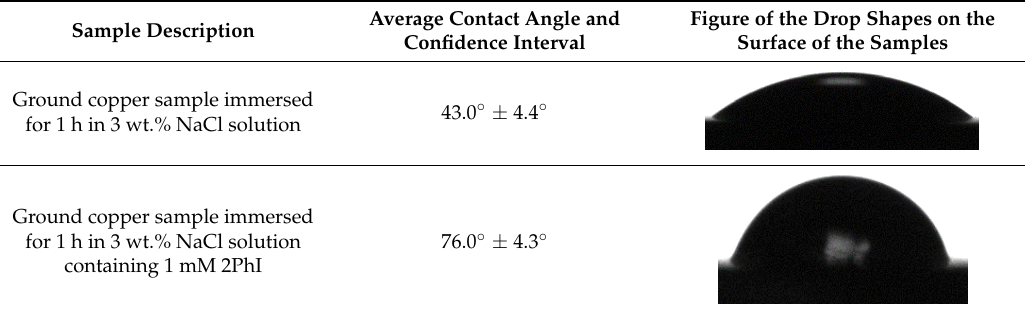
Table 2. The average contact angle values (with the respective 95% confidence intervals [14]) and the drop shapes for the copper samples immersed for 1 h in noninhibited [6] and 2PhI-inhibited 3 wt.% NaCl solutions at 25 °C.